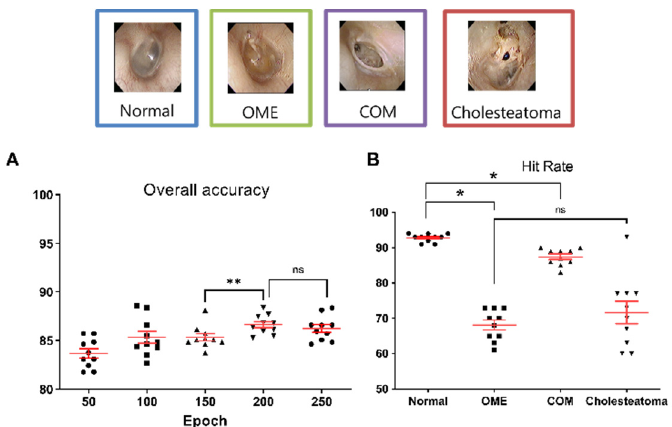
Figure 6. Accuracies and hit rates for differentiating between normal, otitis media with effusion, chronic otitis media, and cholesteatoma. ( A ) Overall accuracies of the machine learning model, according to epoch. (** indicates p -value less than 0.05 with Mann–Whitney test, ns meant non-significant difference). ( B ) Mean hit rates for normal (92.8%), otitis media with effusion (68.1%), chronic otitis media (87.4%), and cholesteatoma (71.7%). (* indicates p -value less than 0.05 with Mann–Whitney test, ns meant non-significant difference).